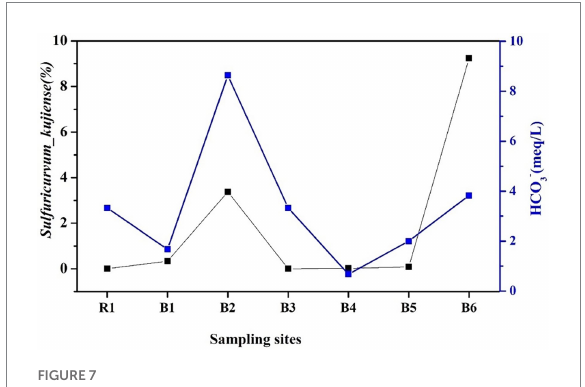
FIGURE 7 Variation in bicarbonate concentrations and the relative abundance of bacterial species at different